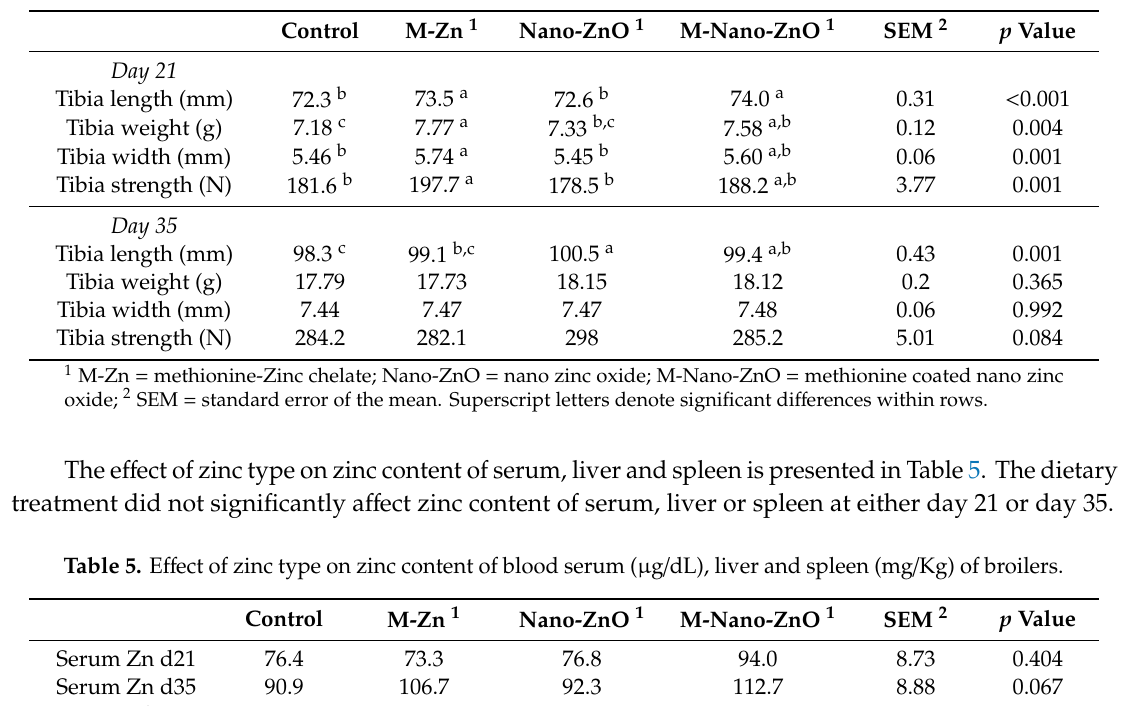
Table 4. E ff ect of zinc type on tibia length, width, weight and strength of broilers.